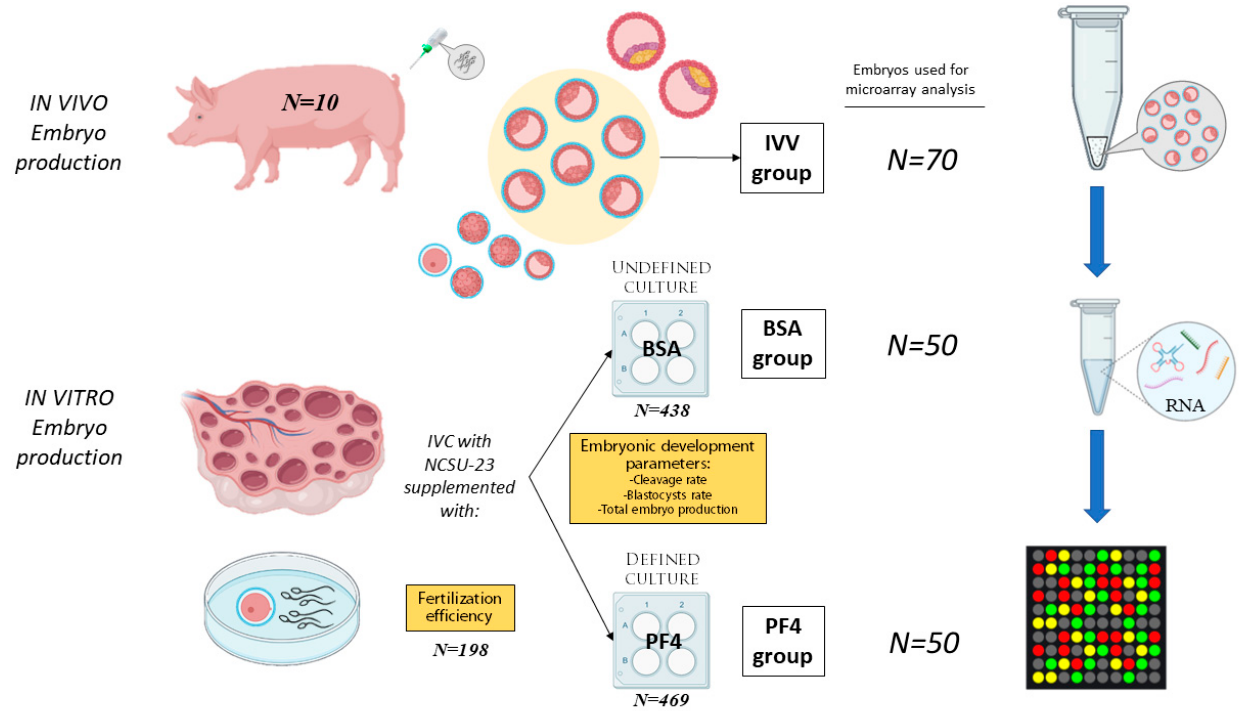
Figure 1. Representation of the experimental design conducted during the study. The samples consisted of pools of 10 blastocysts classified as ZP-covered and expanded. A total of three experimental groups were used, one of which consisted of surgically in vivo-obtained embryos (IVV group) and the other two consisted of embryos produced in vitro; the first one was cultured with undefined culture medium consisting of North Carolina State University (NCSU)-23 supplemented with 0.4 mg/mL bovine serum albumin (BSA group), and the second was cultured with a defined culture medium consisting of NCSU-23 supplemented with 0.3 mg/mL polyvinyl alcohol (PVA) and 100 ng/mL platelet factor 4 (PF4 group). The RNA was extracted from the pools and processed for microarrays. A total of 7 arrays were performed for the IVV group while 5 were performed for each in vitro group. IVC: in vitro culture